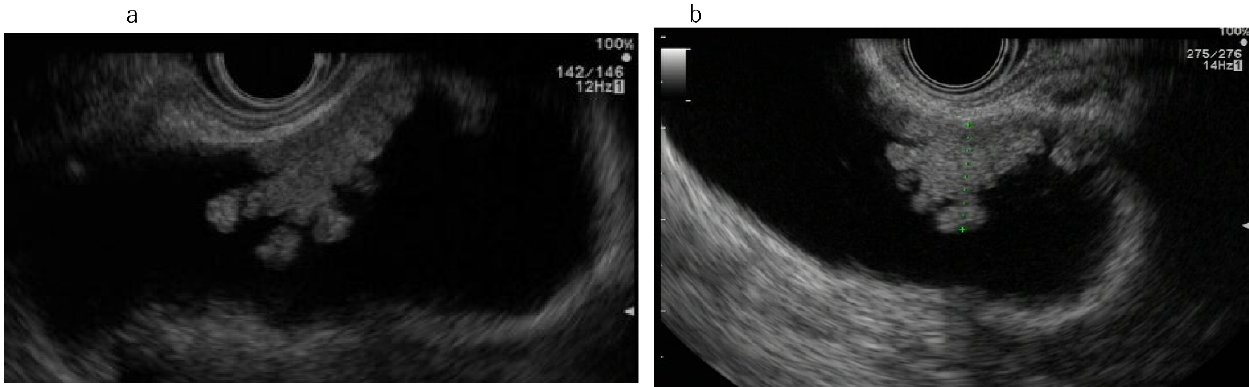
Figure 2. Gallbladder adenoma. ( a ) Endoscopic ultrasonography (EUS): Pedunculated elevated lesion (arrow). ( b ) EUS (Doppler mode): Linear blood flow in the peduncle.